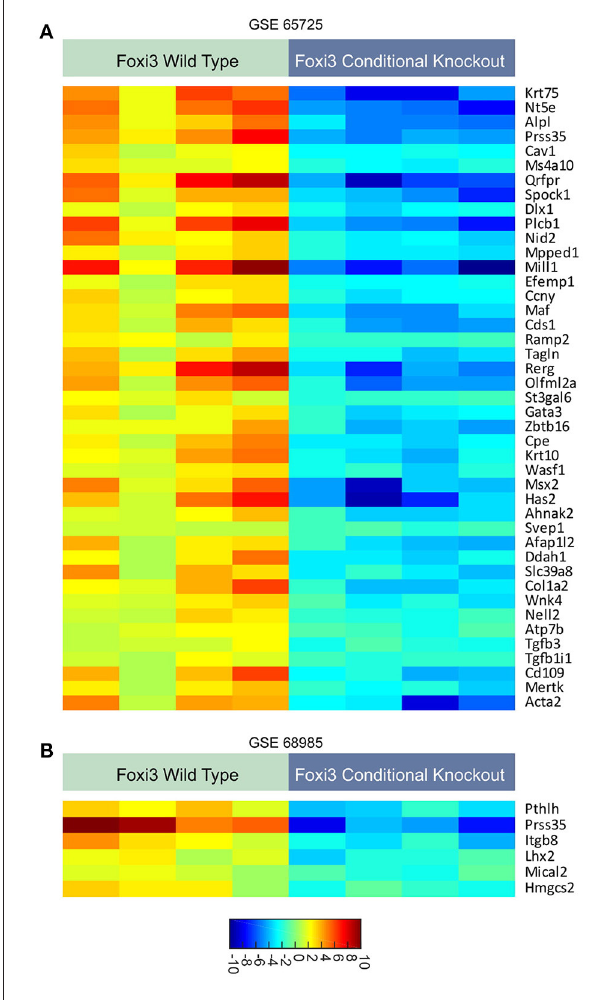
FIGURE 1 | (A,B) Expression patterns of genes regulated with loss of FOXI3 . Data from two published studies (Jussila et al., 2015; Shirokova et al., 2016) (accession numbers: GSE65725 and GSE68985) following download of series matrix files, data median centered, column standardized, and significant gene expression changes were identified using significant analysis of microarray (SAM) ( Tusher et al., 2001). All depicted genes had a q -value < 0.0001.